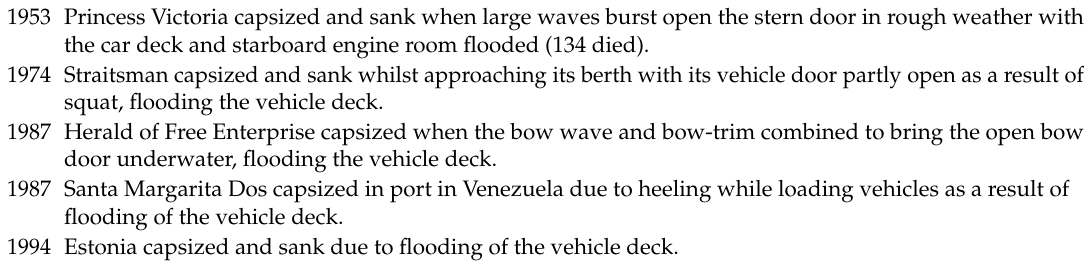
Table 2. RoPax disasters due water on the vehicle deck.